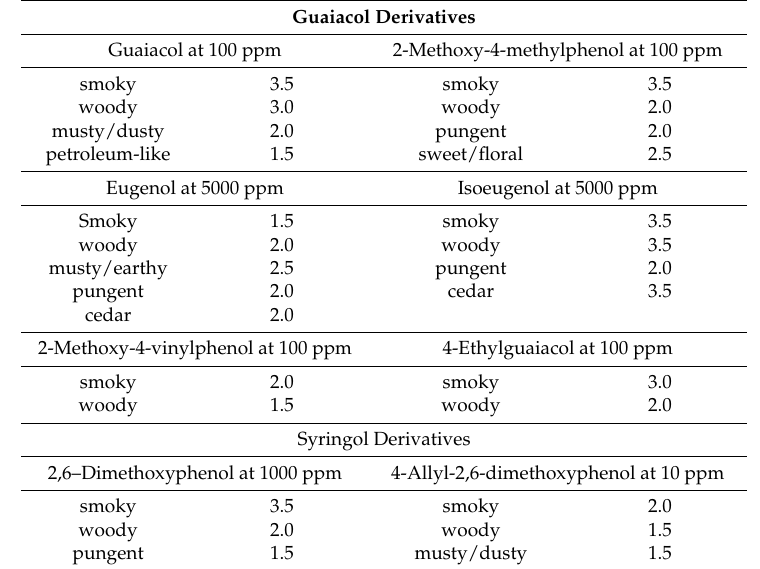
Table 4. Odor profiles of guaiacol derivatives and syringol derivatives illustrating smoked characteristics with descriptions and intensities